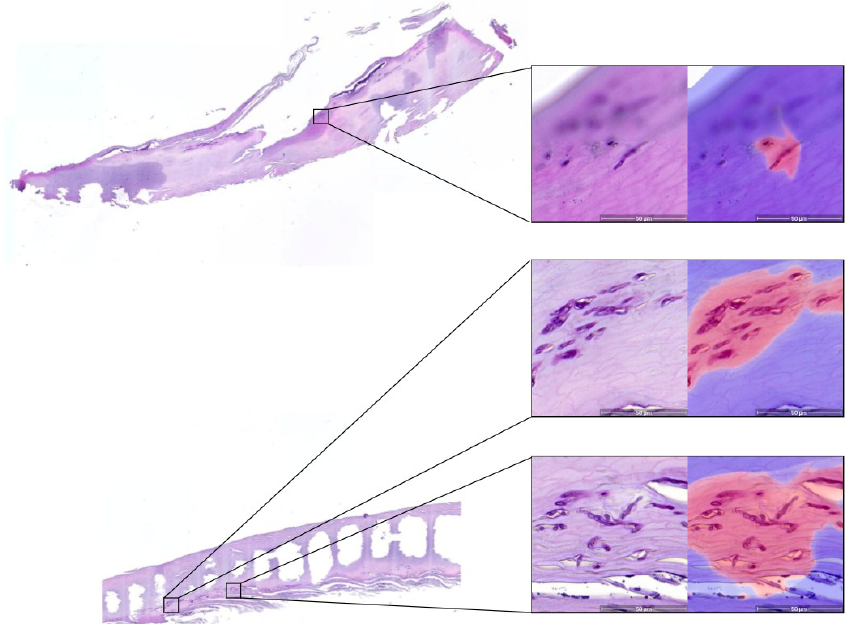
Figure 2. Detection of tinea on whole-slide images. Demonstrated are examples of correctly detected tinea on whole-slide images. Left: an overview of the entire nail section processed; right: zoomed-in examples showing the PAS-stained tinea elements and calls by the algorithm detecting tinea elements, with red pixels representing Tinea. Blurry area on the top image shows areas of the slide where the nail material was not in focus.